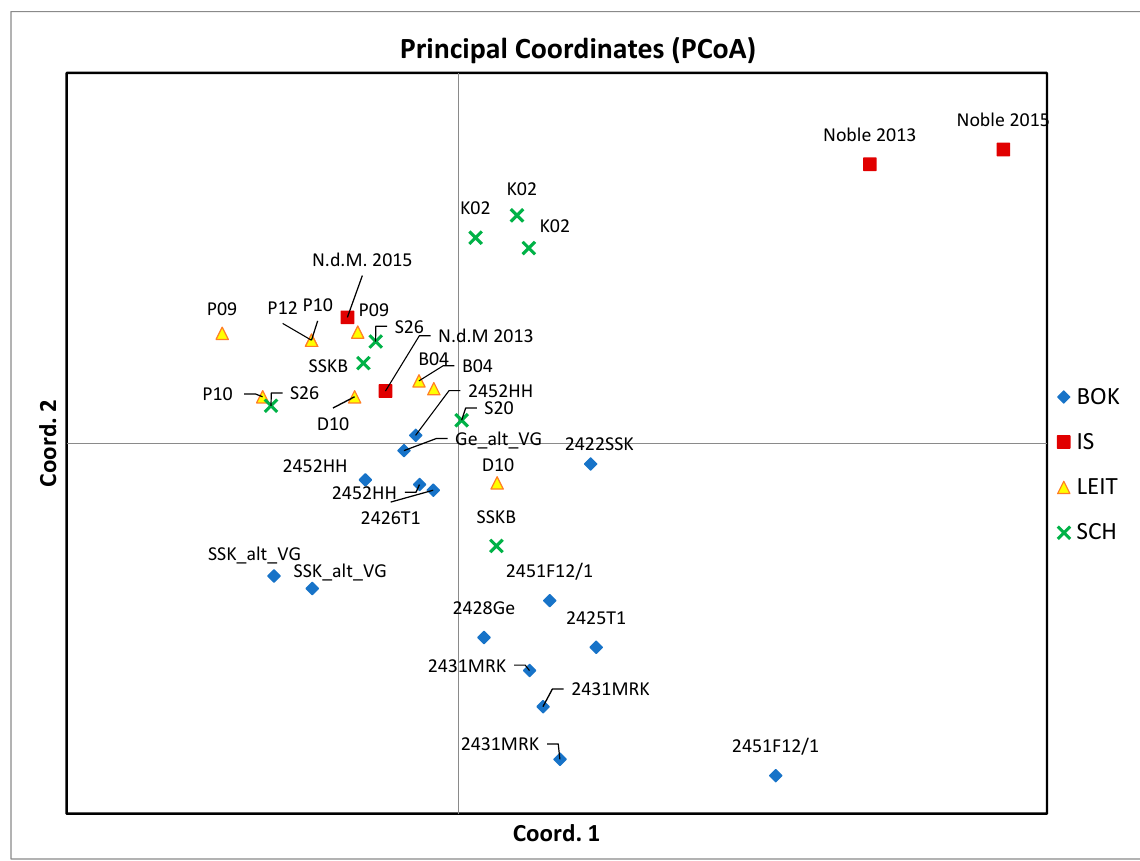
Figure 5. Principal Coordinates 1 and 2 (% of var. explained: 32.7%) of AFLP-data of sweet cherry accessions. Blue: BOK = BOKU, red: IS = International Standard, yellow: LEIT = Leithaberg, green: SCH = Scharten.